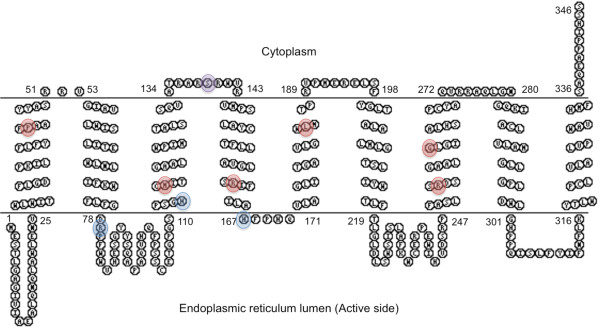
Predicted topology of G6PC3 with missense mutations. Residues substituted by missense mutation are highlighted by red circles and the laboratory generated substitutions by blue circles. The S139 residue, predicted in previous publications to be substituted by c.416G > T mutation is highlighted by purple circle. Our analysis suggests that the c.416G > T might be a splice-site mutation (see main text for discussion).